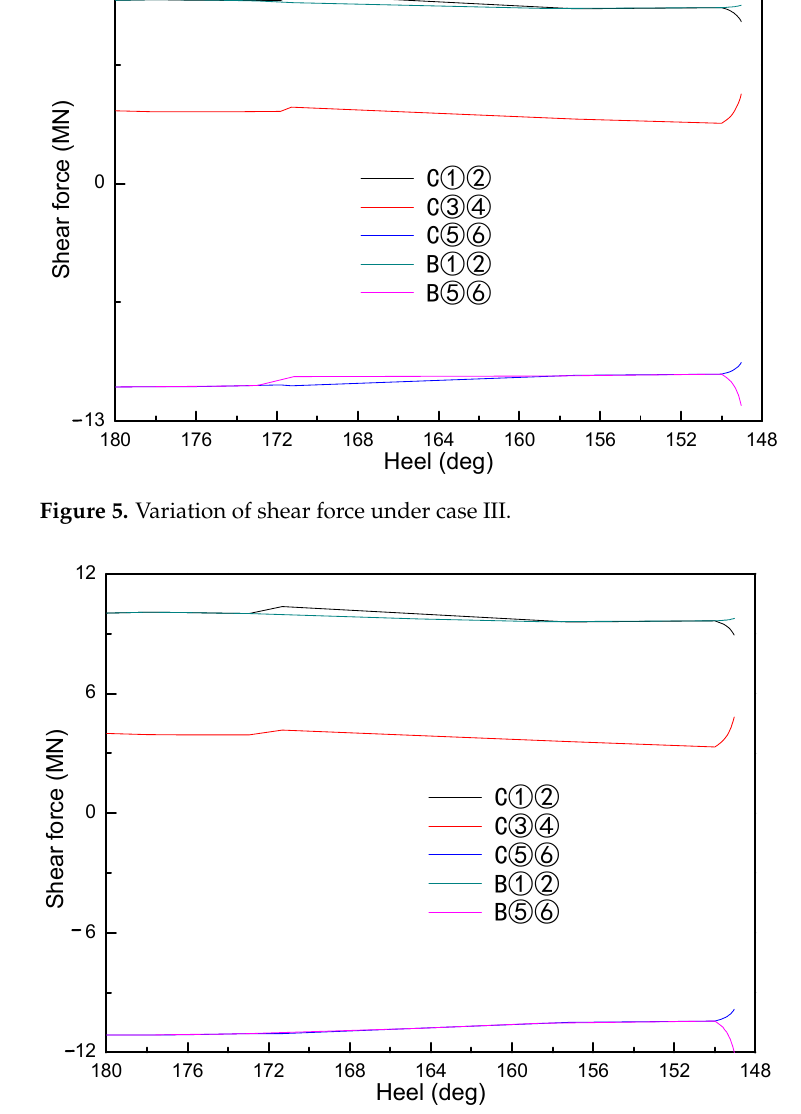
Figure 6. Variation of shear force under case IV. The shear force of most righting force points in various cases decreases gradually (shown in Figures 3–6), but the shear force of case III C 3 (cid:13) 4 (cid:13) , case III A 3 (cid:13) 4 (cid:13) , case IVC 3 (cid:13) 4 (cid:13) , and case IV A 3 (cid:13) 4 (cid:13) increase gradually, as illustrated in Figures 5 and 6. The shear forces of the righting force point of different schemes under various cases are close to each other. The shear force difference of C 1 (cid:13) 2 (cid:13) and B 1 (cid:13) 2 (cid:13) increases when the heel angle decreases; the maximum differences are, respectively, 1.66%, 4.05%, 9.97%, and 9.233%, and C 1 (cid:13) 2 (cid:13) is smaller than B 1 (cid:13) 2 (cid:13) . The shear force difference of C 5 (cid:13) 6 (cid:13) and B 5 (cid:13) 6 (cid:13) increases when the heel angle decreases, the maximum difference is, respectively, 3.70%, 8.80%, 2.16%, and 2.00%, and C 5 (cid:13) 6 (cid:13) is smaller than B 5 (cid:13) 6 (cid:13) . The shear force difference of C 3 (cid:13) 4 (cid:13) and A 3 (cid:13) 4 (cid:13) increases when the heel angle decreases, and the maximum difference is 1.72%. By comparing scheme A with scheme C, the shear force did not decrease, and part of the righting force of scheme C may be used to control the attitude of the ship. In scheme B and scheme C, the change of shear force at the righting point in each working condition gradually increases, among which C 3 (cid:13) 4 (cid:13) and B 5 (cid:13) 6 (cid:13) increase greatly. In the salvage process, attention should be paid to the influence of wind force on the local force of the